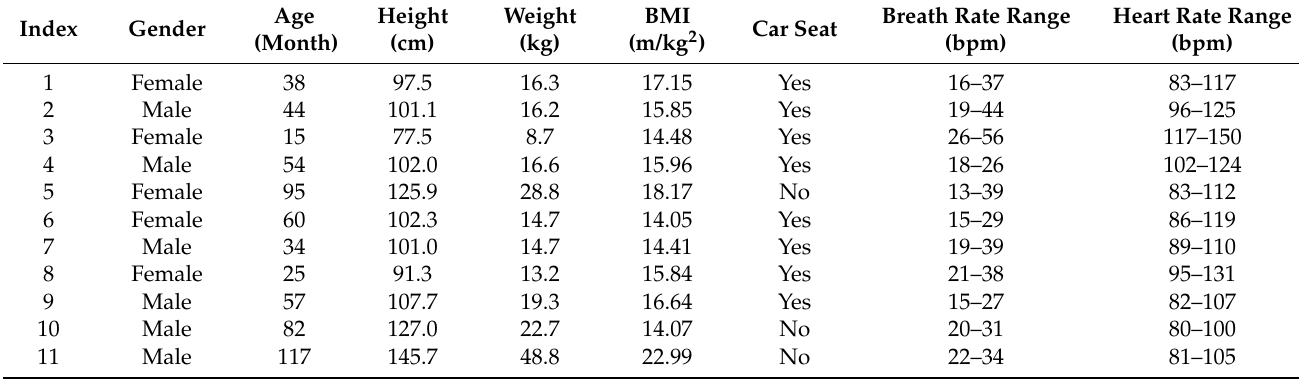
Table A1. 50 involved children in data acquisition process. Column 8 and 9 represent the beats per minute (bpm) range of each participant obtained from Nihon